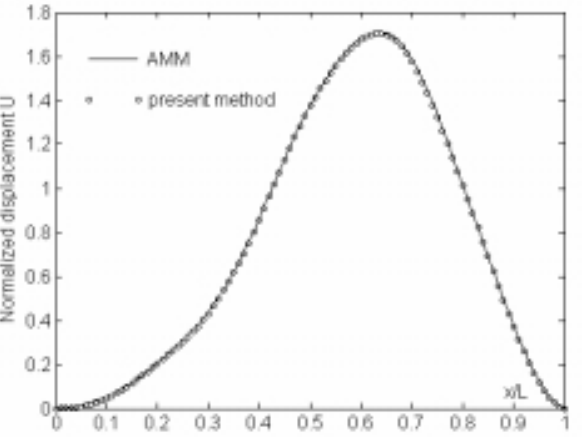
Fig. 4. Normalized displacement under a moving force with α =0.50 and a beam with β = 0 . 15